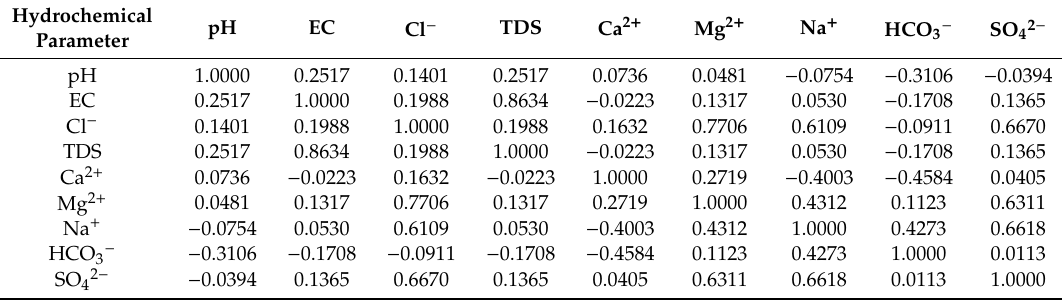
Table 3. Matrix plot of the physicochemical groundwater